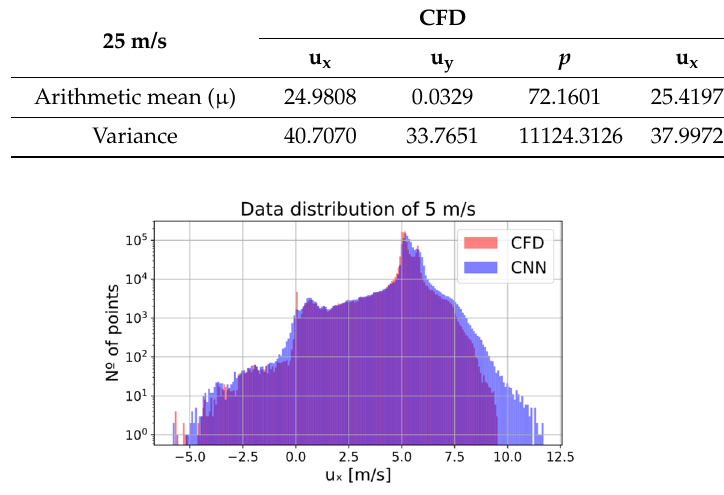
Table 5. Comparison of arithmetic mean and variance between the ground-truth CFD data and the CNN predictions for the streamwise velocity of 25 m/s.